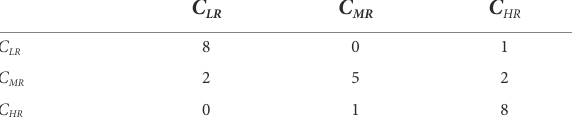
TABLE 2 Confusion matrix for Bayes Classifier. TABLE 3 Confusion matrix for KNN